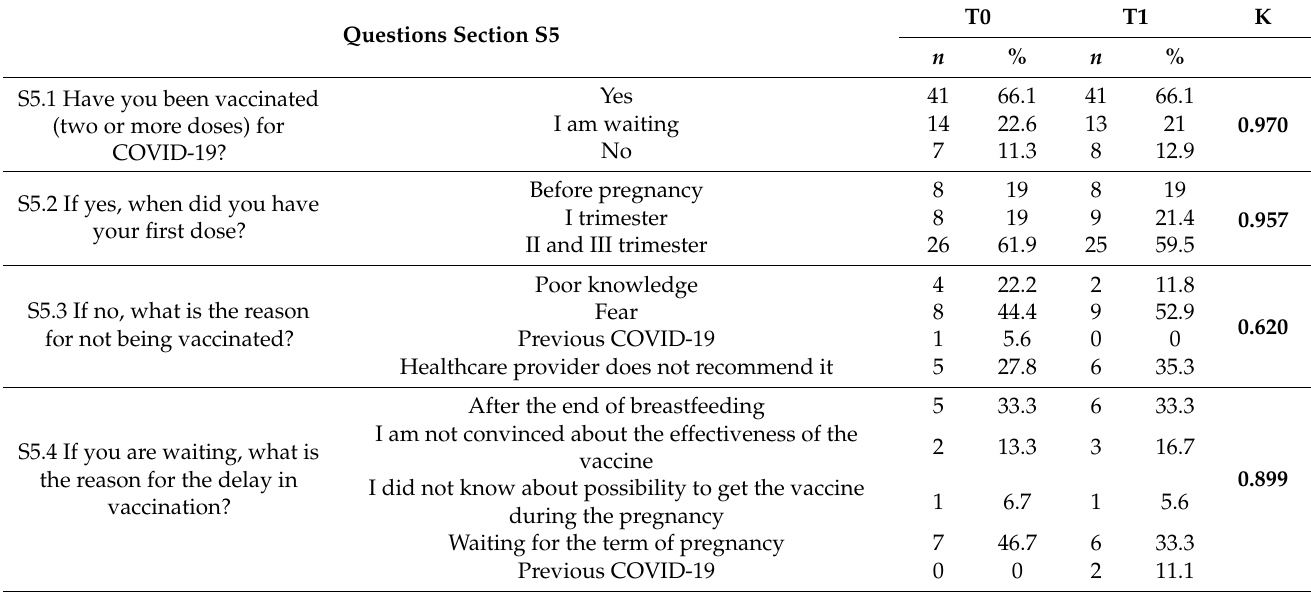
Table 6. Descriptive and reliability of “Section S5: Personal position about COVID-19 vaccination” ( n =